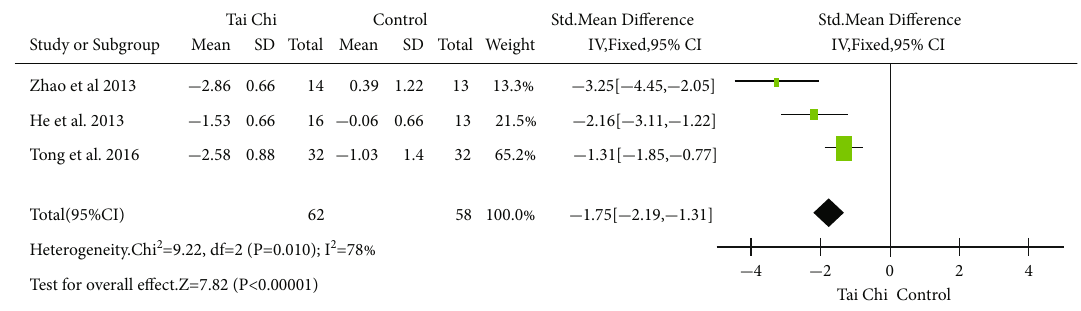
Figure 10: Forest plot of Oswestry disability index for Tai Chi for disability.